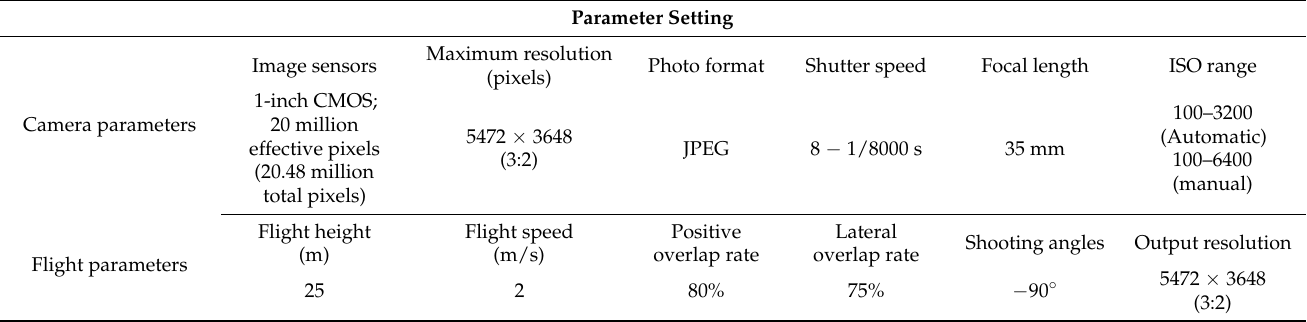
Figure 3. Schematic diagram of UAV-based image acquisition of asphalt pavement. Table 1. Parameters of high-precision cameras used in UAV.